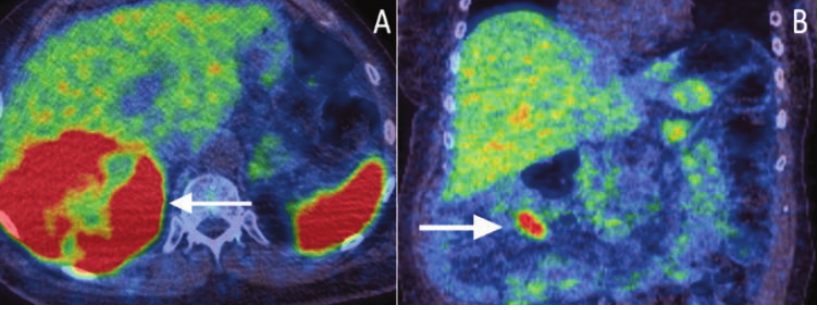
symptoms of 4.8 years has been demon- strated in one retrospective study of 200 patients post cardiac surgery.